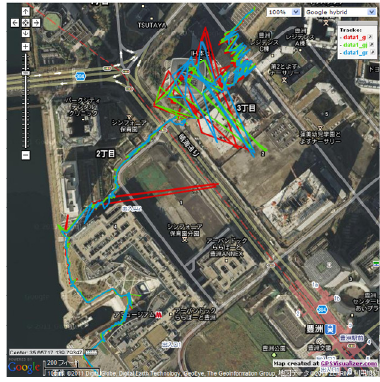
Figure 10. A result from the our outdoor experiment